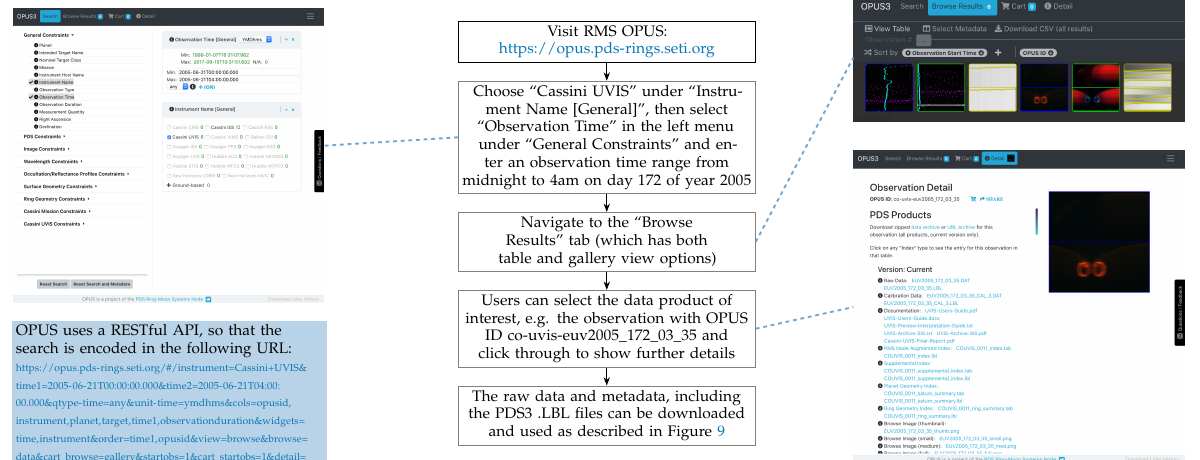
Figure 10. Step-by-step instructions on how to find and obtain UVIS data from the PDS via RMS OPUS for an observation of Saturn’s aurora carried out around 03:35 on day 172 of year 2005. All links in this figure were accessed on 30 October 2022.